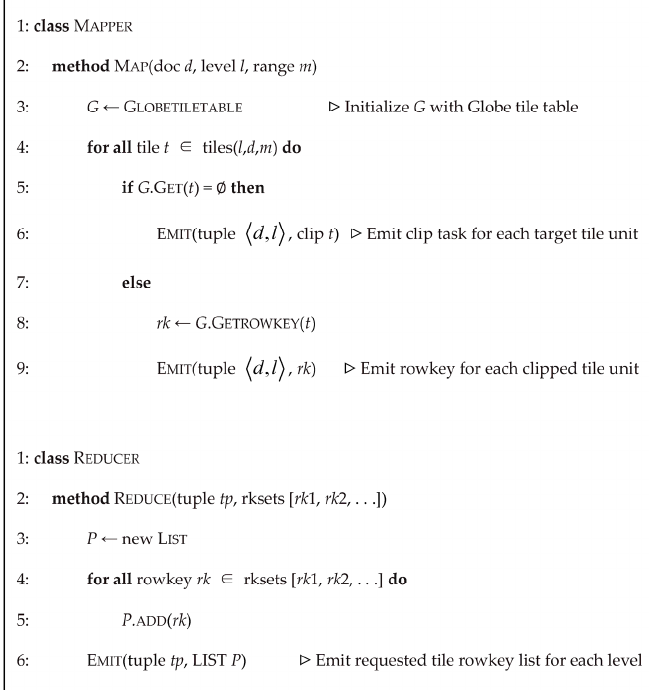
Figure 12. Pseudo-code for the dynamic tile-clip algorithm in MapReduce.